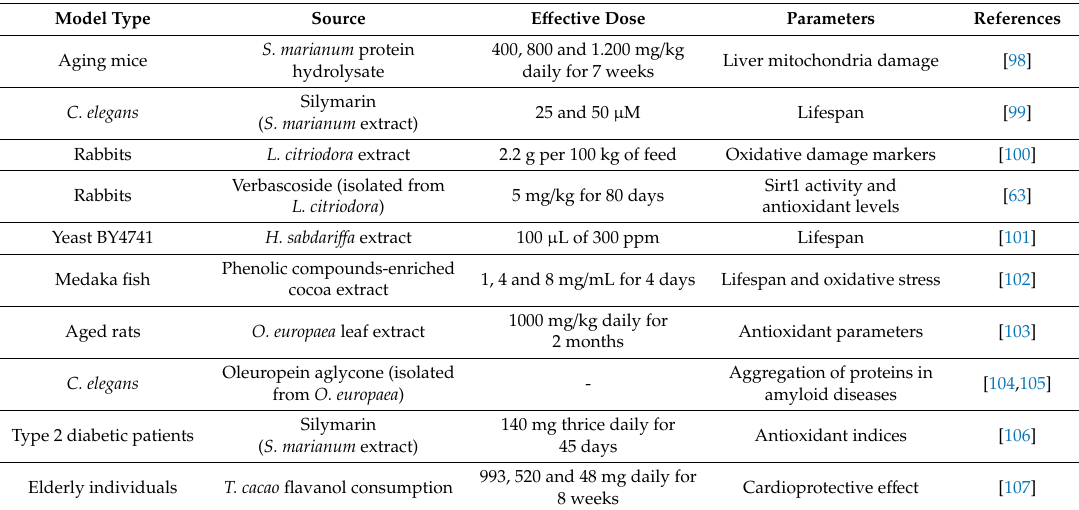
Table 3. In vivo studies of the included sources on the main metabolic pathways related to